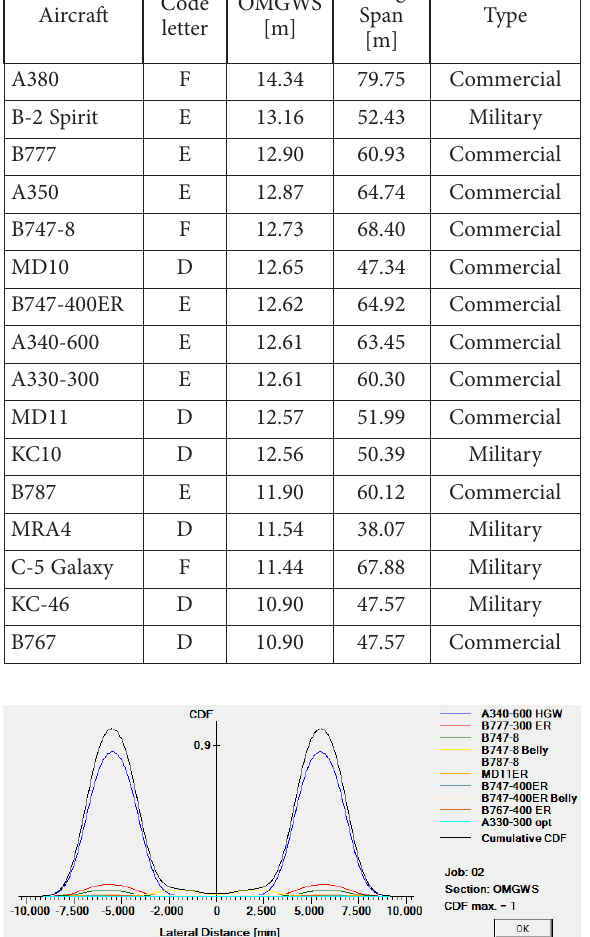
Figure 3. Aircraft lateral landing load distributions